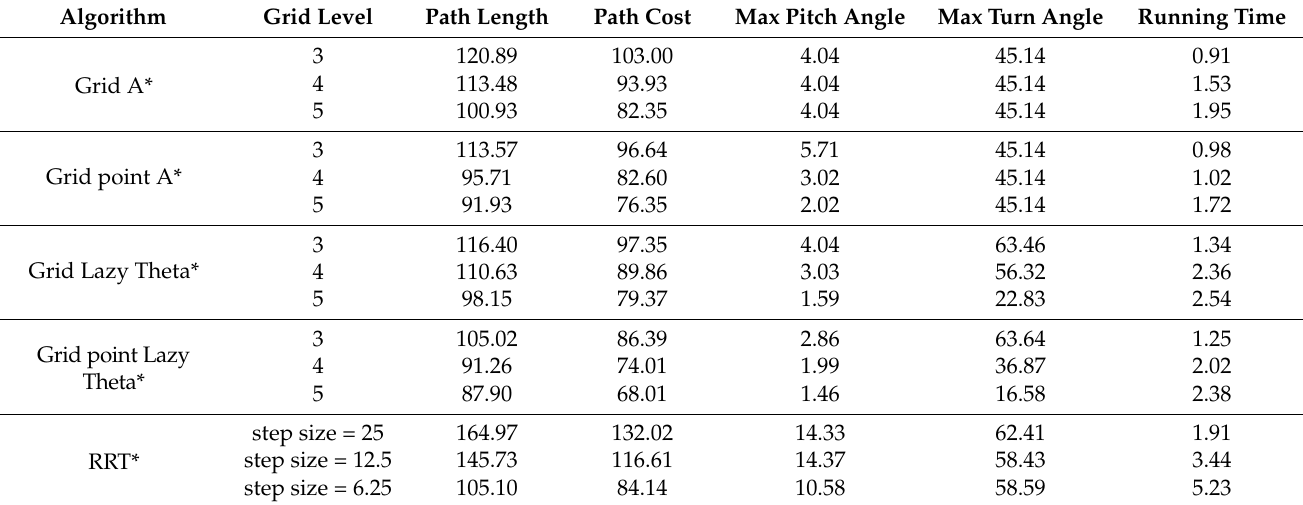
Table 2. Multi-scale grid comparison